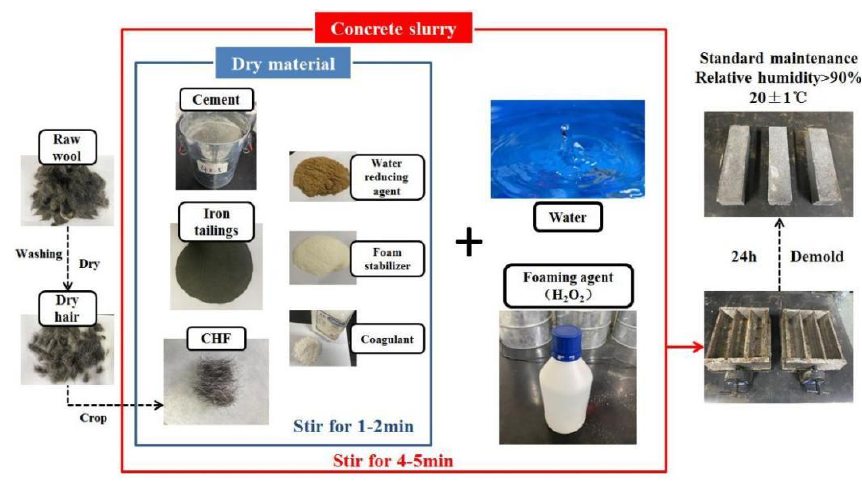
Figure 2. Schematic diagram of the preparation process. Table 1. Mixing proportions.